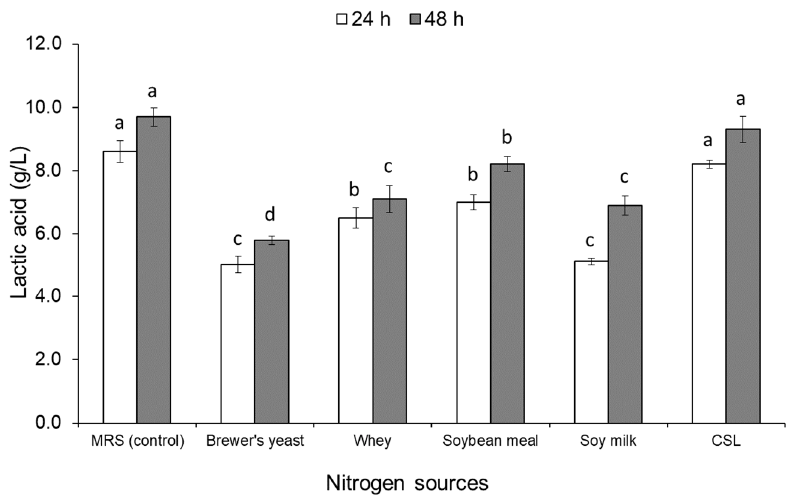
Figure 1. Lactic acid production from various nitrogen sources using L. plantarum S21 under static conditions at 37 °C for 24 h (white column) and 48 h (gray column).